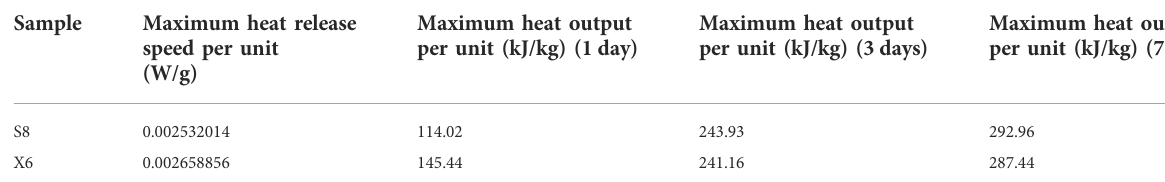
TABLE 10 Heat of hydration of samples at different ages.